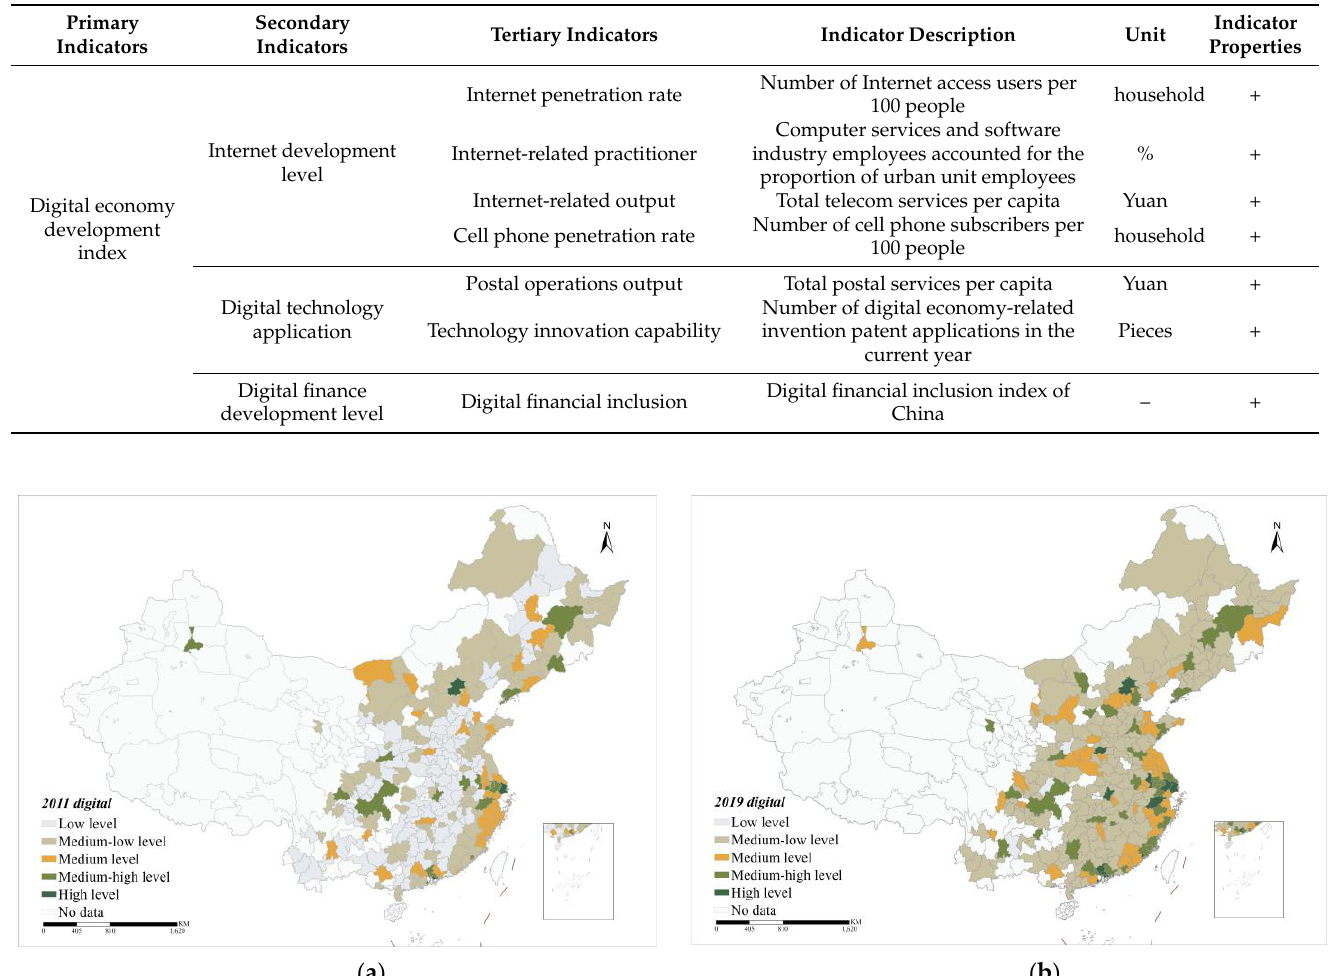
Table 2. Evaluation system of the digital economy development index.